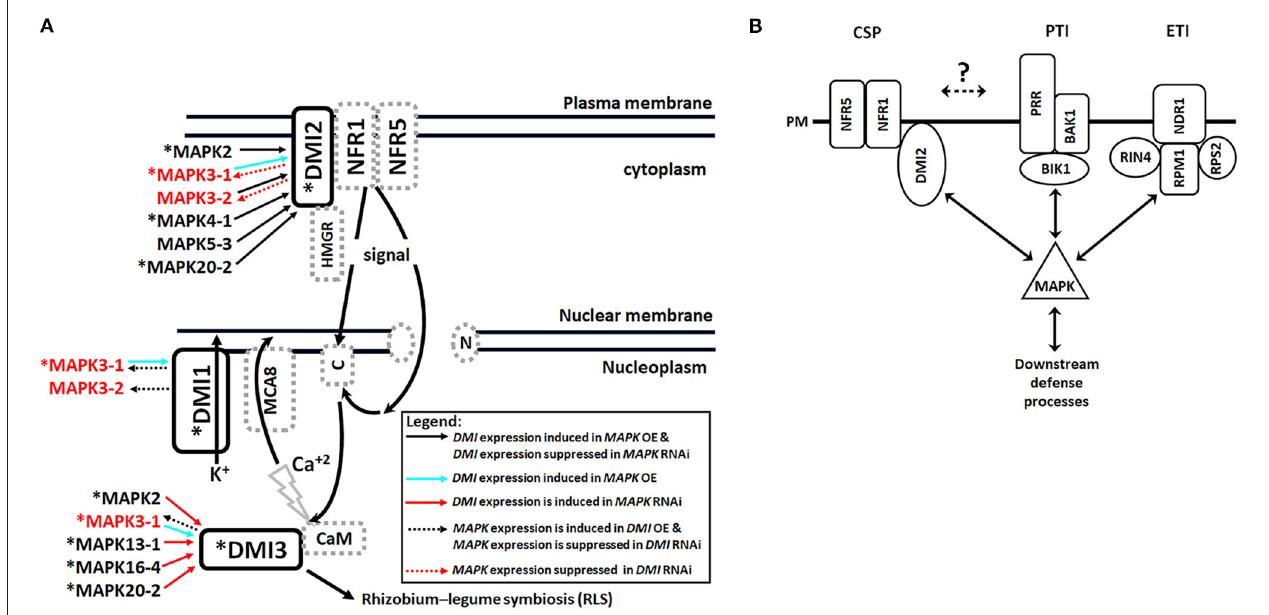
FIGURE 7 | Model. (A) The plasma membrane (PM) receptor DMI2 which interacts with HMG-CoA reductase (3-hydroxy-3-methyl-glutaryl-coenzyme A reductase) (HMGR), and Nod factor receptors (NFR1 and NFR5), propagate signals that migrate either directly through the nuclear membrane or through nucleoporins (N), leading to the generation of calcium waves that involve the Type IIA calcium ATPase MCA8, and necessary to activate calmodulin and DMI3. The process concludes with an effective Rhizobium -legume symbiosis (RLS). The signaling process involves the engagement of the potassium channel DMI1. RNA-seq analyses, confirmed by RT-qPCR experiments, highlighted that some of the MAPK s undergoing transgenically-altered expression affects DMI RTAs as presented as their FC. Some of the involved MAPKs were determined to be expressed in syncytia undergoing the defense response (asterisk [*]) (McNeece et al., 2019). *expressed in syncytia undergoing a defense response. (adapted from Genre and Russo, 2016). (B) The G. max CSP, PTI, and ETI pathways converge on MAPK signaling, leading to downstream processes that function in defense to H. glycines parasitism. The hashed arrow between the CSP and PTI and ETI receptors is positioned because questions remain whether they directly influence their relative abundances